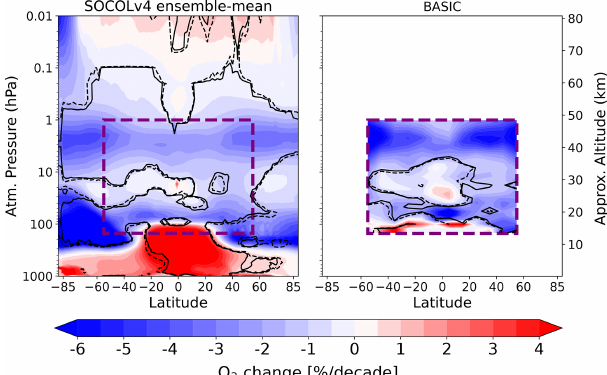
Figure 4. Ozone changes per decade (in %) for the ozone depletion phase (between 1985 and 1997) from the ensemble mean SOCOLv4 reference experiment and the BASIC observational composite. The dashed line is the delimiter of the region with significance at the 90% level for positive or negative changes; the solid line is the same at the 95% level. The dashed purple line indicates the region for which the BASIC composite is